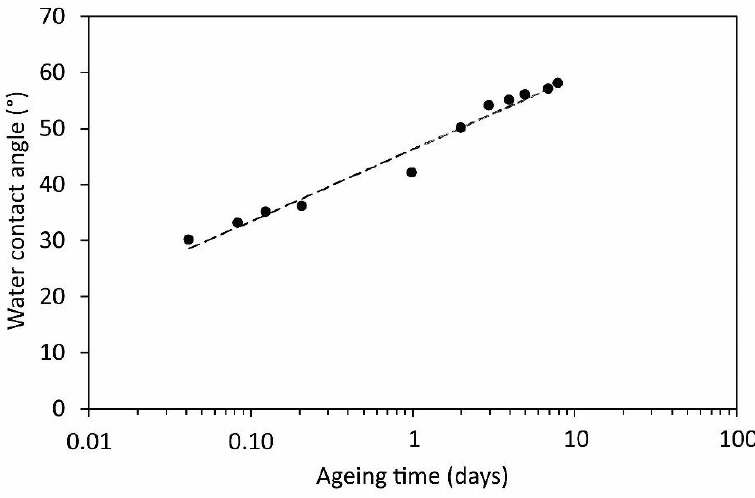
Figure 13. The evolution of the minimum water contact angles versus aging time.